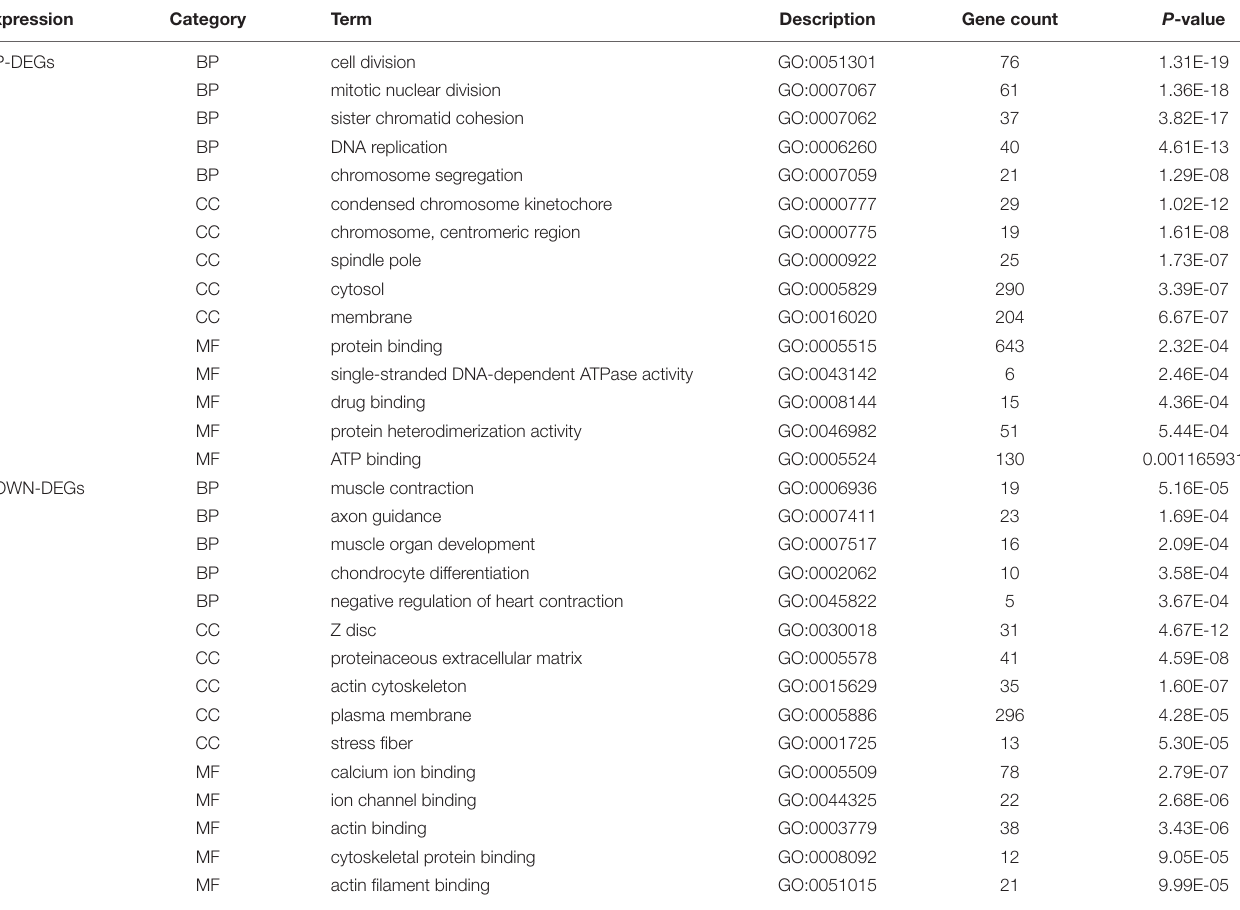
TABLE 3 | Enriched